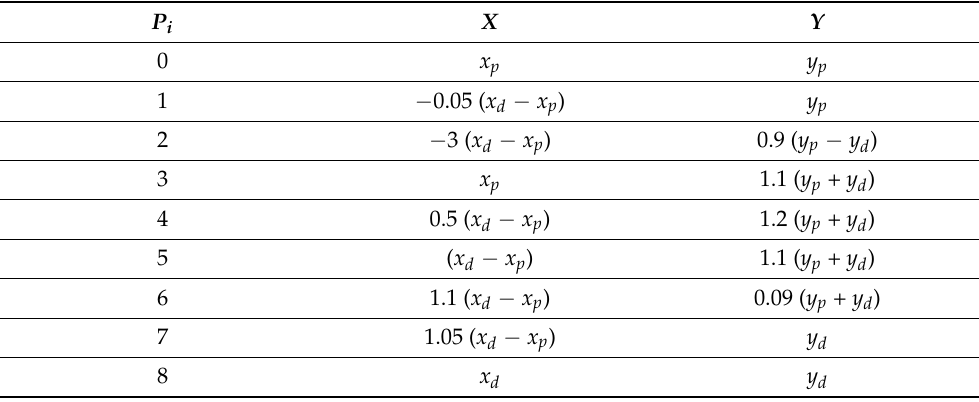
Table 1. Bezier curve control